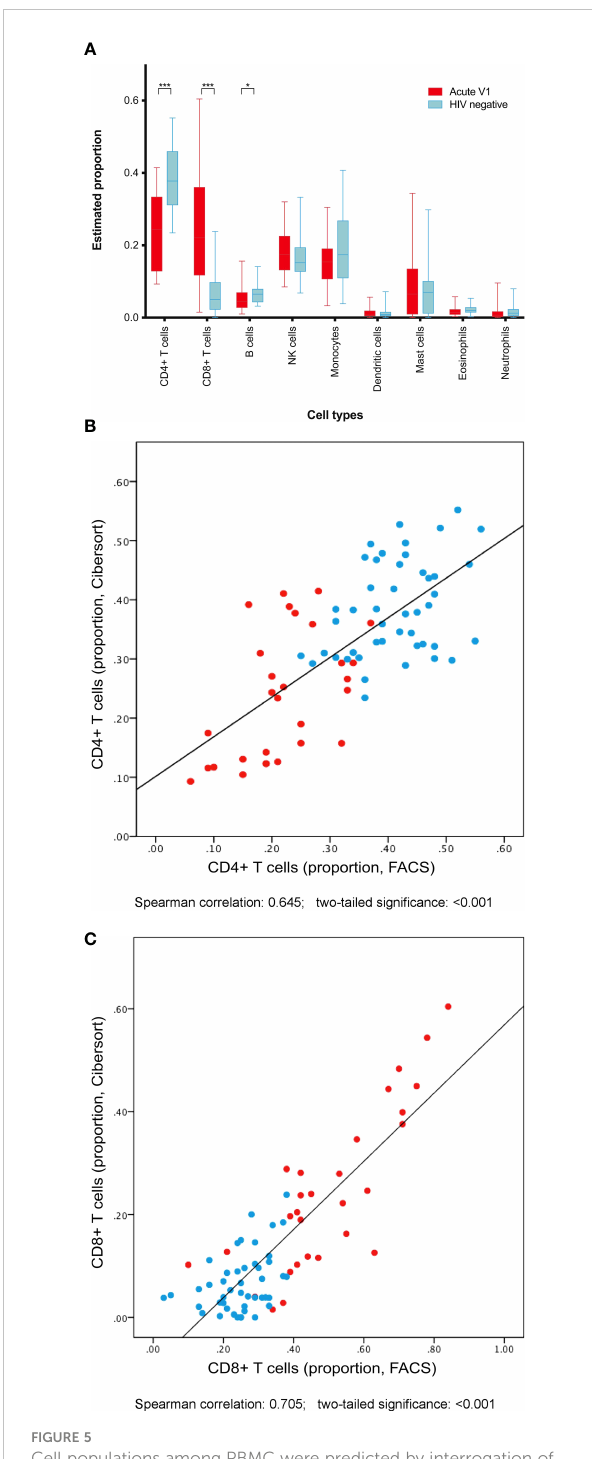
FIGURE 5 Cell populations among PBMC were predicted by interrogation of differential gene expression between acute HIV cases and uninfected controls. (A) Acute HIV was associated with predictable declines in CD4+ T cell and B cell populations, and expansion of CD8+ T cells. Both CD4+ T cell counts (B) and CD8+ T cell counts (C) estimated using gene expression data correlated well with cell counts via fl ow cytometry. *p<0.05. ***p<0.001